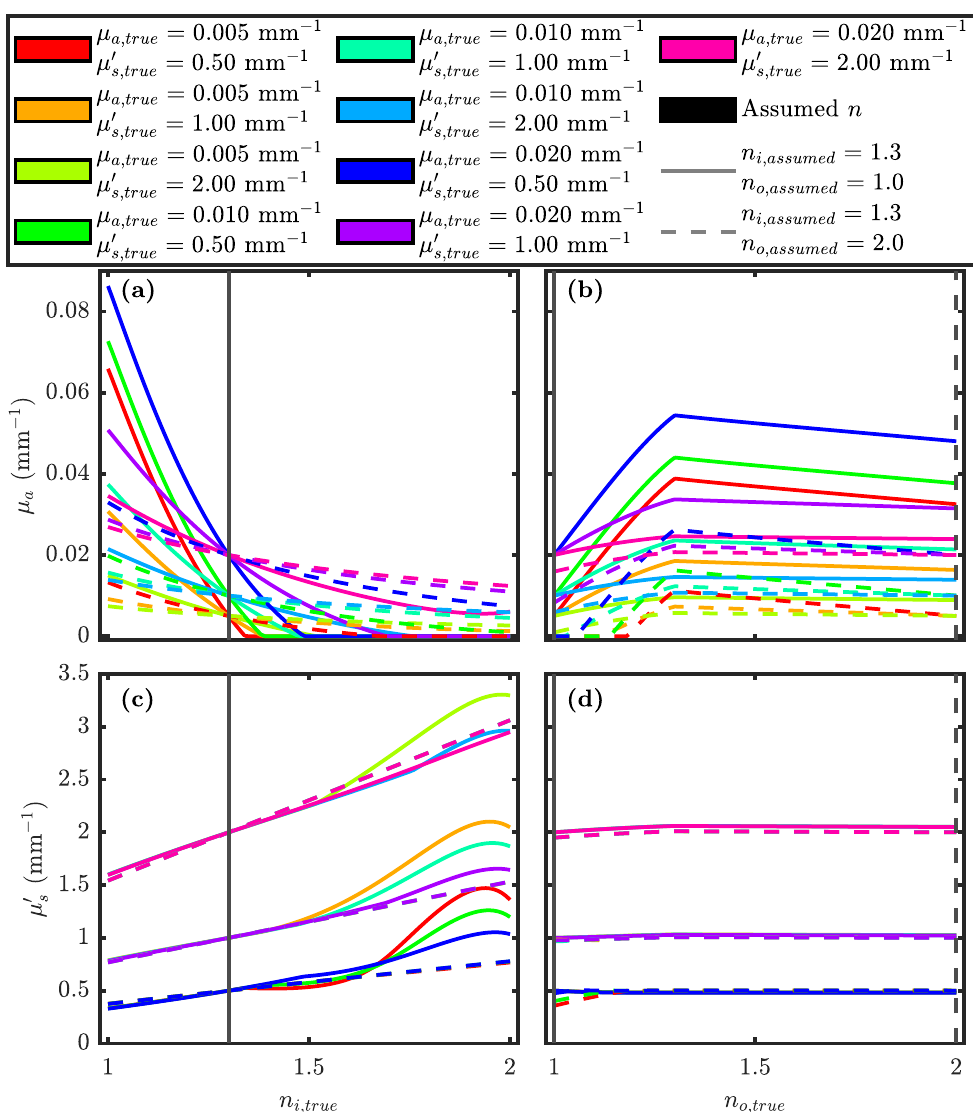
Figure 9. Effect of recovered µ a and µ (cid:48) s on the true n inside ( n i ) and outside ( n o ) when fixed values of n s are assumed . Shown for the 9 sets of optical properties used in Figure 6. ( Solid Lines ) n i = 1.3 and n o = 1.0 assumed in fit. ( Dashed Lines ) n i = 1.3 and n o = 2.0 assumed in fit. ( a ) Recovered µ a while varying n i , true and fixing n o , true to the assumed value. ( b ) Recovered µ a while varying n o , true and fixing n i , true to the assumed value. ( c ) Recovered µ (cid:48) s while varying n i , true and fixing n o , true to the assumed value. ( d ) Recovered µ (cid:48) s while varying n o , true and fixing n i , true to the assumed value. Acronyms and Symbols: Absorption coefficient ( µ a ), reduced scattering coefficient ( µ (cid:48) s ), and index of refraction ( n